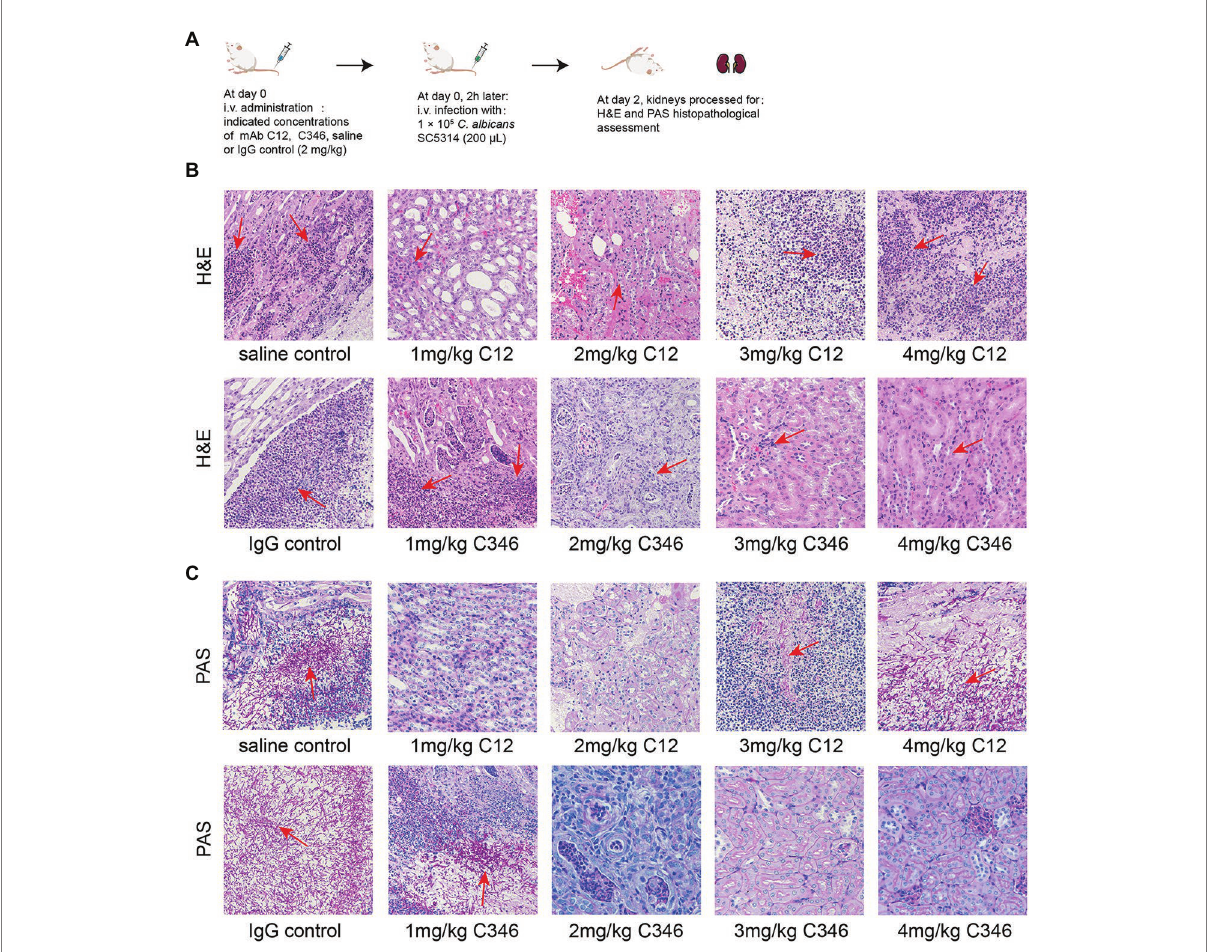
FIGURE 3 The effects of pre-treatment with mAb C12 or mAb C346 on renal histopathological damage in the murine model of disseminated candidiasis. (A) Schematic process of pretreatment with mAb C12 or mAb C346 in the murine model of disseminated candidiasis. The kidneys were dissected on day 2 post-infection with C. albicans SC5314. (B,C) Representative histopathological assessments of the kidneys by H&E staining for inflammatory cell influx and extent of tissue necrosis (B) and PAS staining for C. albicans strain (C) . Arrows indicate inflammatory cell influx and tissue necrosis (H&E staining), and C. albicans filaments in the tissues (PAS staining). The representative results of three independent experiments are shown. Magnification 200